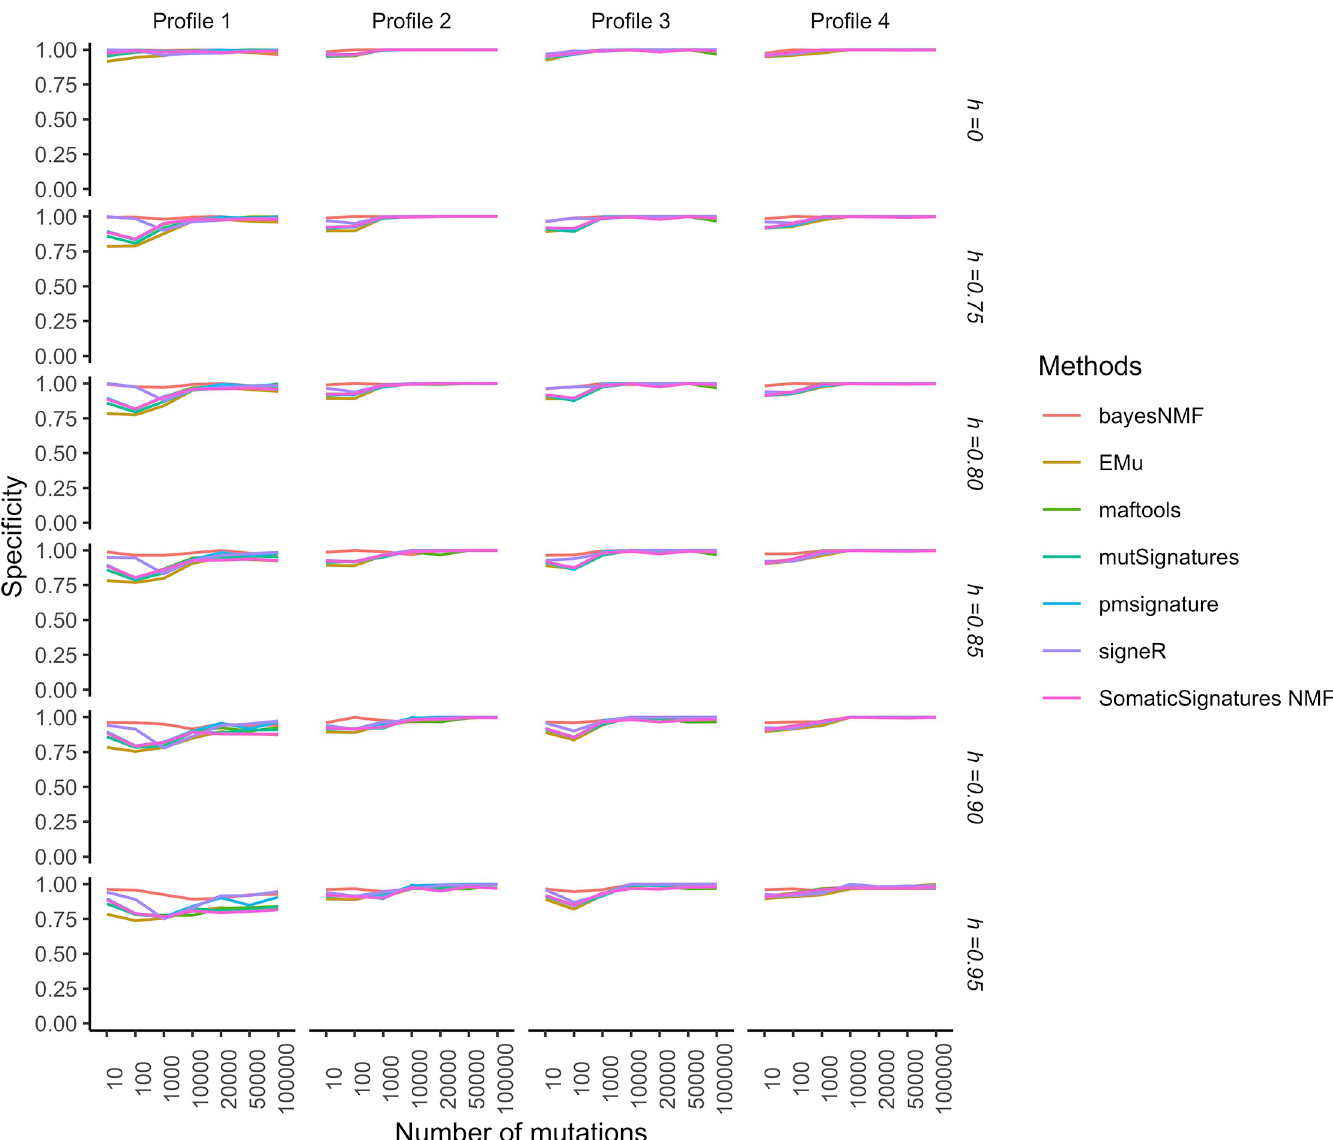
Fig 6. Simulation study: Specificity of extraction methods and mapping on COSMIC signatures as the average number of mutations and the cosine cut-off h vary. Specificity is estimated from 50 replicates each made of G = 30 catalogues. The model used to simulate realistic replicates according to the four Profiles and the estimation methods are described in the section Data and experimental